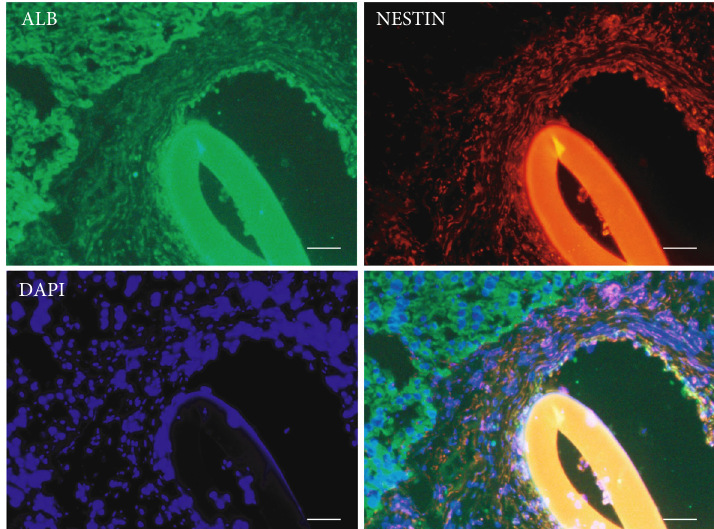
Figure 6: Transplanted EMSC-GC engraft in the rat and can di ff erentiate into HLCs. Hepatic di ff erentiation in vivo was con fi rmed through immuno fl uorescent staining with the stem cell marker (nestin) and the hepatic di ff erentiation marker (ALB) and examined under a microscope. Scale bar = 25 μ m